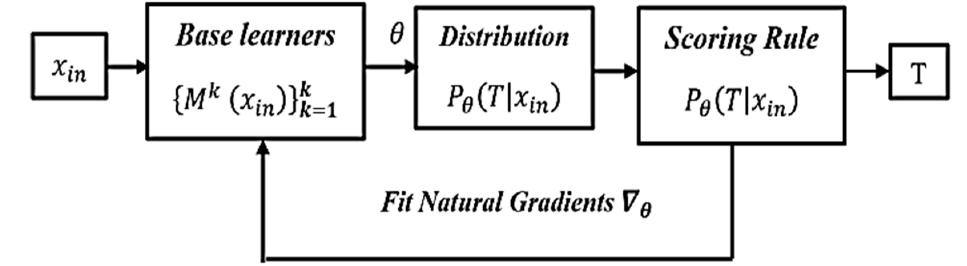
Figure 11. Block diagram representation of NGBoost model.